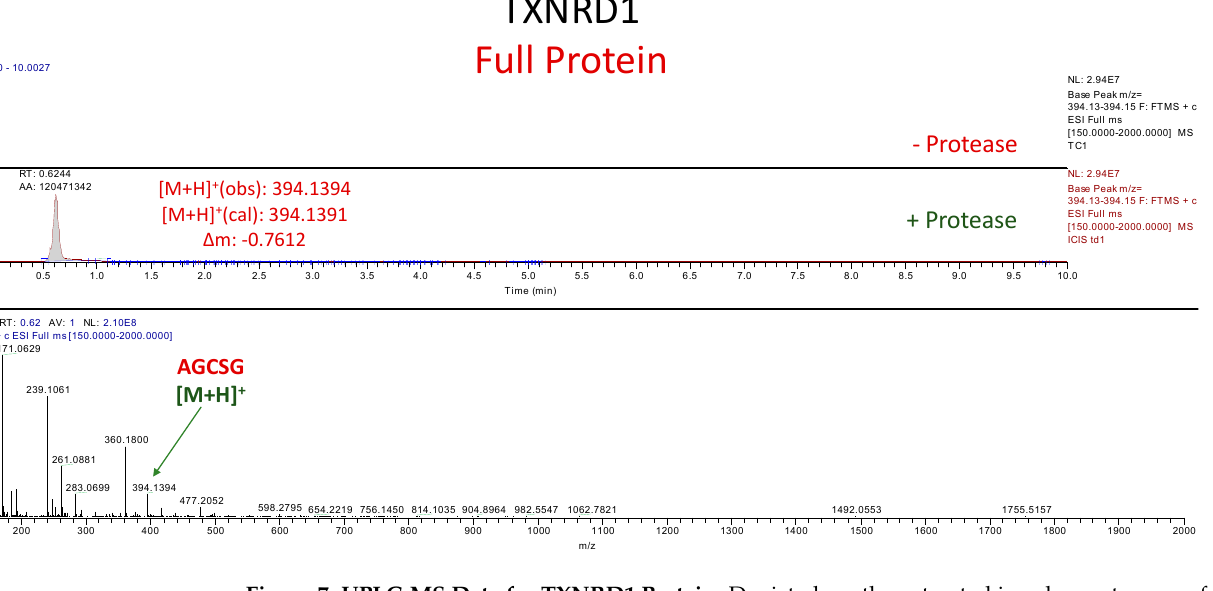
Figure 7. UPLC-MS Data for TXNRD1 Protein. Depicted are the extracted ion chromatograms for the samples without protease and with protease (top) and the mass spectrum for the P ′ Fragment (bottom). High resolution mass spectrometric analysis corroborates the identities of each base peak in the corresponding extracted ion chromatogram.